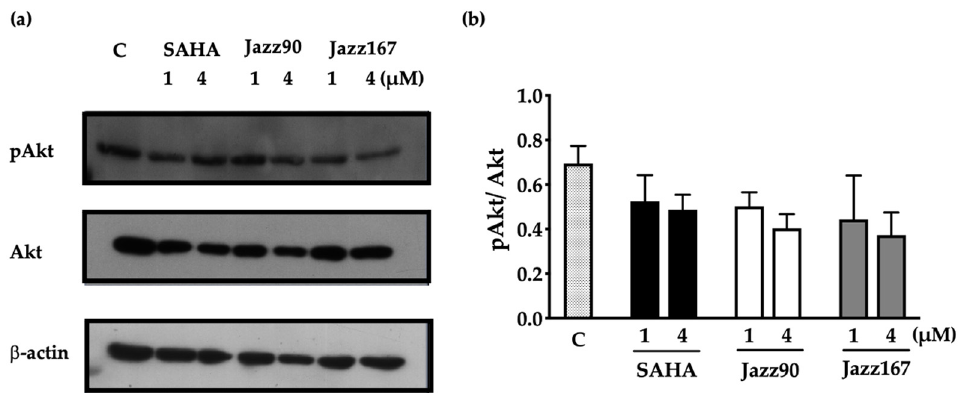
Figure 4. Compound-mediated changes in pAkt/Akt in DU145 cells. DU145 cells were treated with SAHA, Jazz90 and Jazz167 at 1 and 4 µ M. Vehicle control cells (C) were treated with 0.5% DMSO. Cells were harvested 24 h after treatment. Representative Western blots of ( a ) pAkt, Akt and β -actin (loading control) and their ( b ) densitometry are shown. Bars represent the mean ± S.E.M. from 3 independent experiments. Data were analysed using a two-way ANOVA followed by a Bonferroni’s post-hoc test. None were significantly